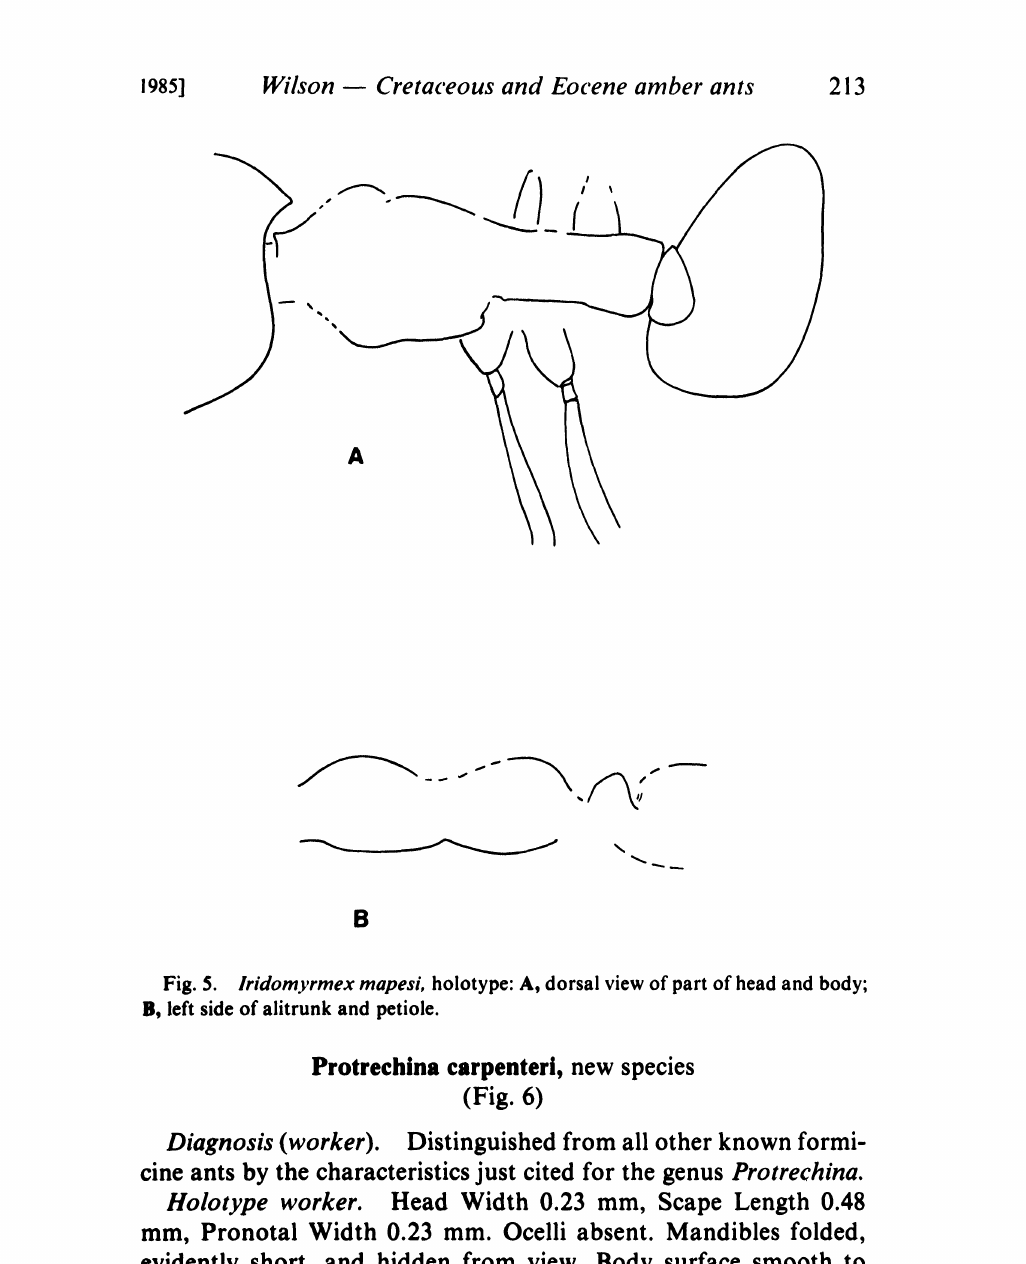
Fig. 5. iridomyrmex mapesi, holotype: A, dorsal view of part of head and body; B, left side of alitrunk and petiole. Protrechina carpenteri, new species (Fig.